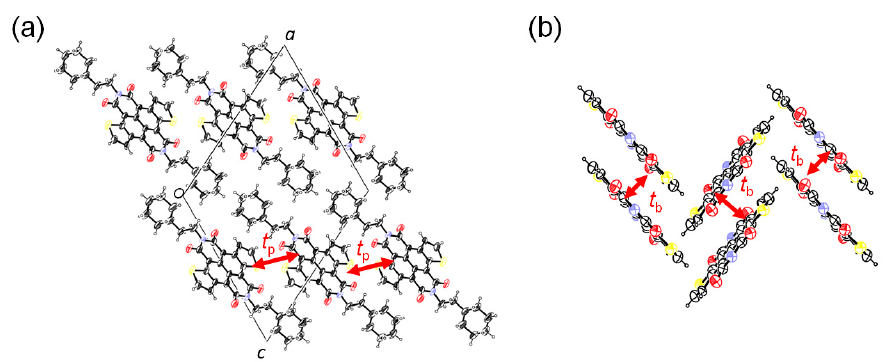
Figure 4. Crystal structure of 3 : ( a ) b -axis projection and ( b ) side view of stacking columnar structure. Calculated transfer integrals of lowest unoccupied molecular orbitals (LUMOs), t p and t b , are 17 and 90 meV, respectively.